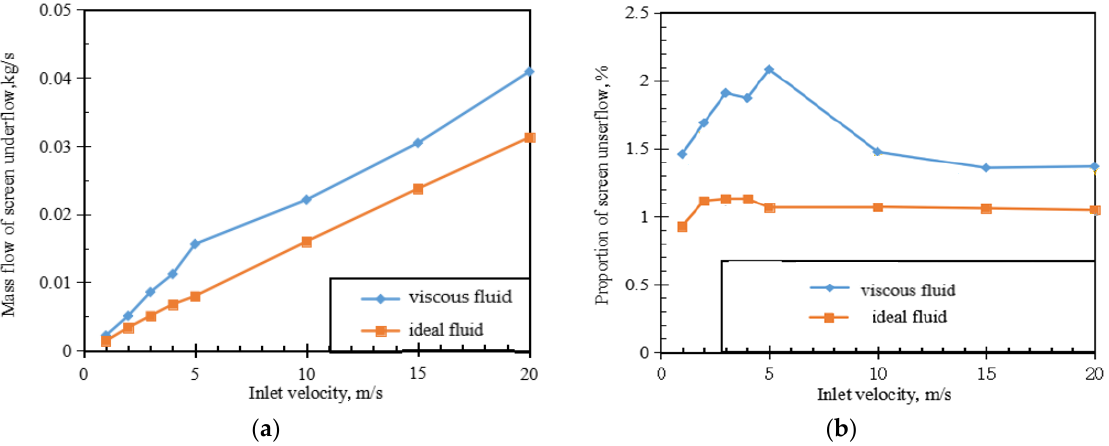
Figure 5. Distribution of ( a ) the mass flow of screen underflow and ( b ) the proportion of screen underflow for ideal and viscous fluid under different inlet velocities (1~20 m/s).